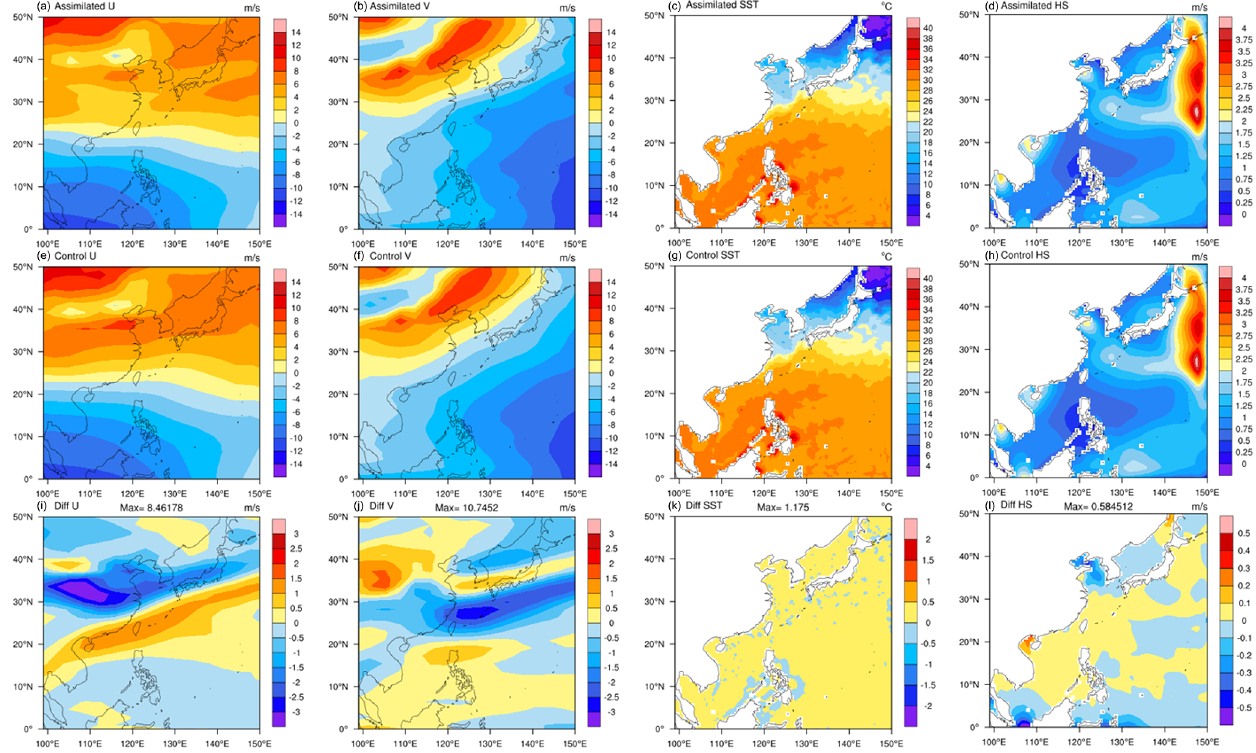
Figure 18. Simulation results of FIO-AOW (at 06:00UTC on 3 June 2016) about the fields of meridional wind ( U ; the first column) and zonal wind ( V ; the second column) produced by WRF, sea surface temperature (SST; the third column) produced by POM, and sea surface significant wave height (HS; the fourth column) produced by MASNUM. The first row shows the results of the full example DA system predicted since 00:00UTC on 3 June, based on the DA experimental setup in Sect. 5.1, the second row shows the results without DA, and the third row is the corresponding